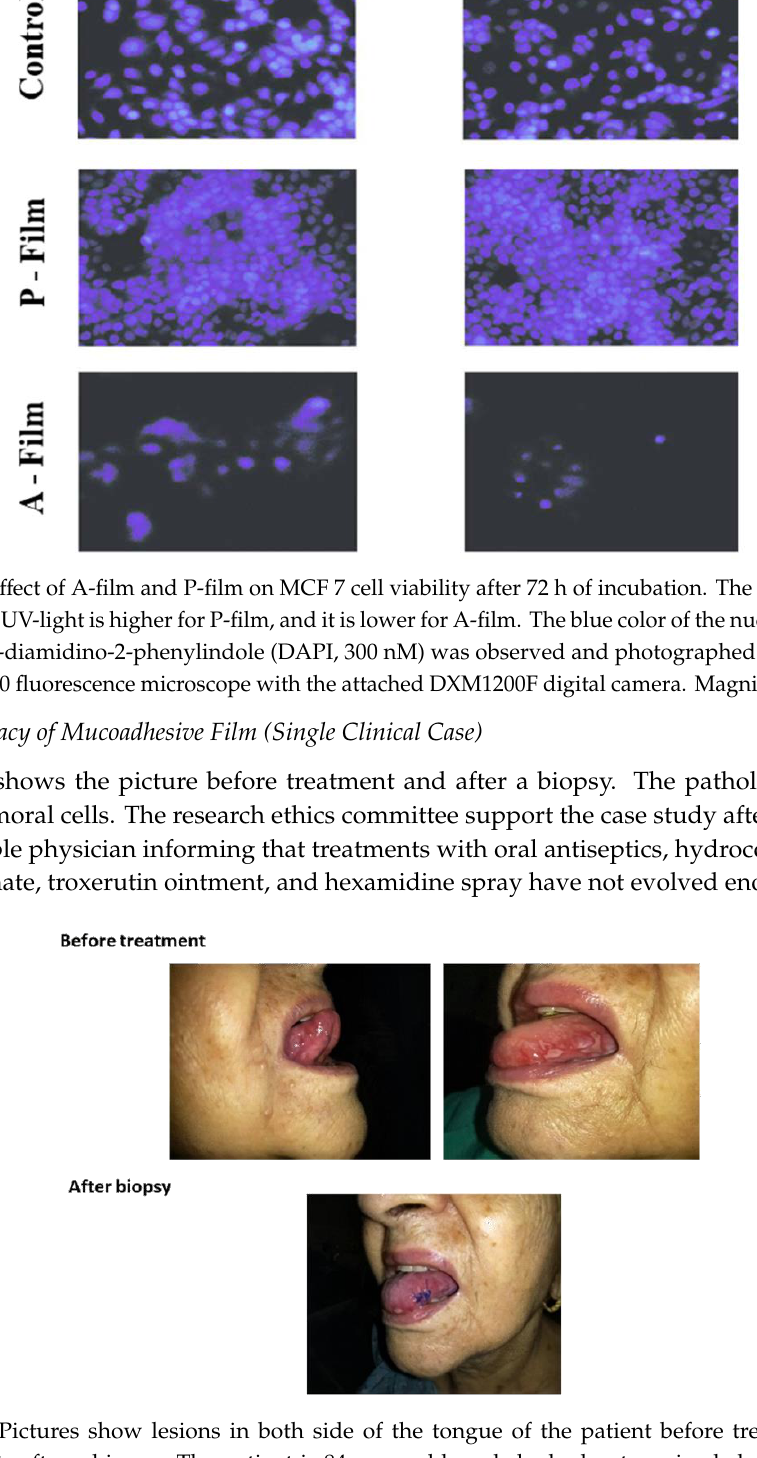
Figure 10. Morphology of MCF-7 cells after 24 h in the presence of P-film (Panel A ) and A-film (Panel B ). The micrographics picture shows compact colonies with a typical epithelial polygonal shape of MCF 7 cells. Magnification 40×.